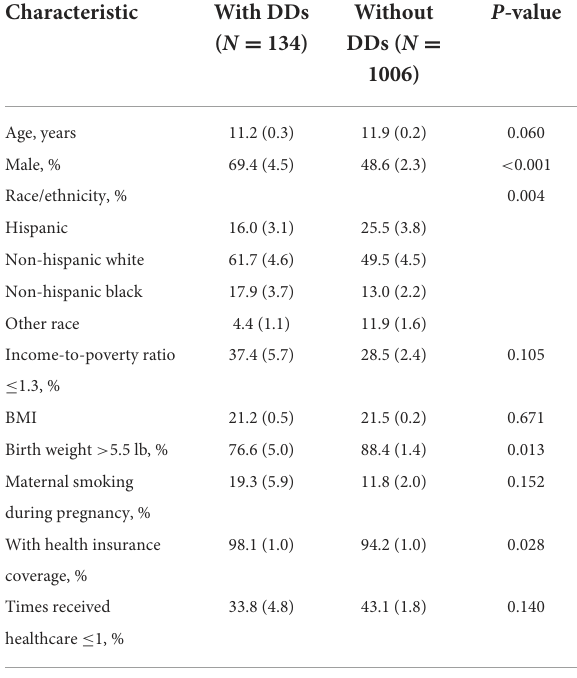
TABLE 1 Characteristics of children included in NHANES 2013–2016